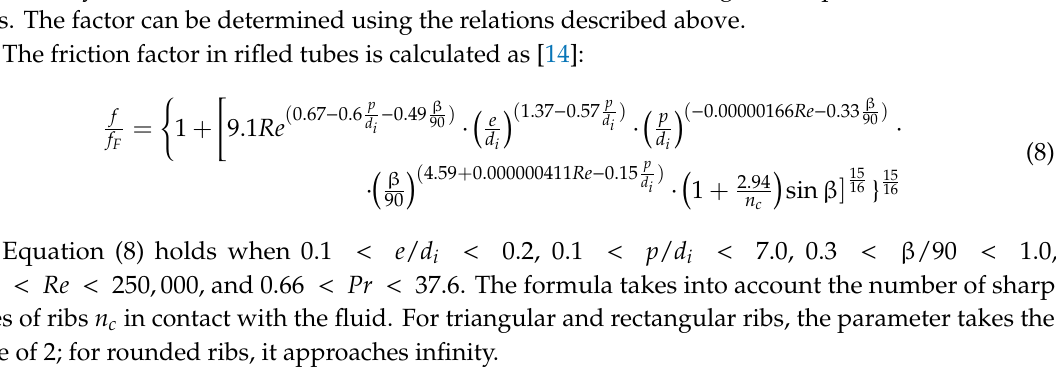
Figure 1. Geometrical dimensions of rifled tubes: ( a ) Transverse section, ( b ) longitudinal section, ( c ) rib detail. a —Rib width at the base; b —rib average width; d o —outer diameter; d i —inner diameter (with no ribs); d min —minimum diameter with ribs; e —rib height; g —wall thickness; p—rib pitch; α —rib extension apex angle; β —rib helical angle.